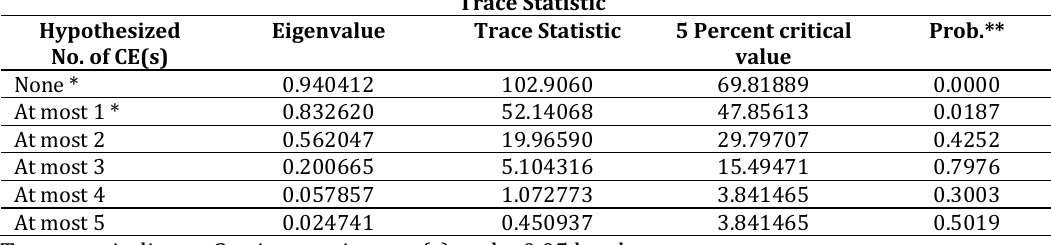
Table 2: Johansen co-integration test using trace statistic